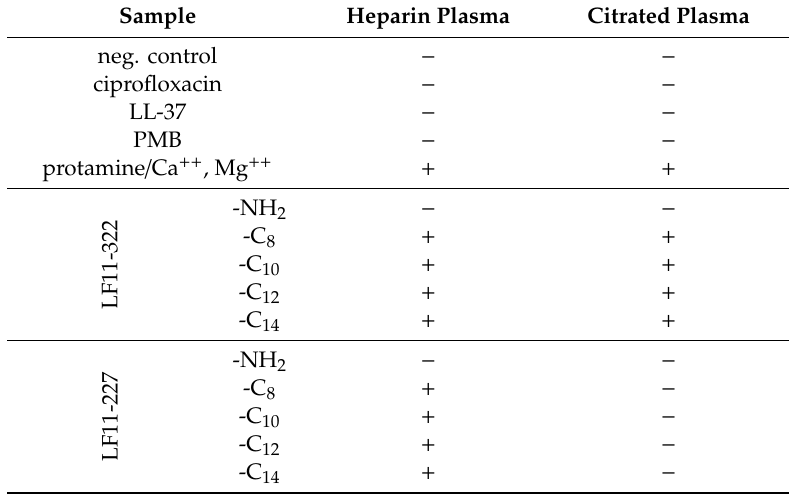
Table 3. Influence of AMPs on plasmatic coagulation. AMPs were incubated in citrated and heparinized plasma to determine if they can activate the plasmatic clotting